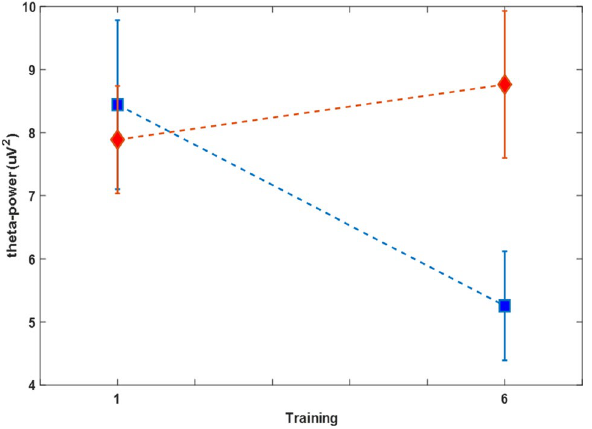
Figure 5. Pain evoked theta-band power. Mean power from 200 to 350 ms (3–5 Hz) measure at before the first and before the last BCI-training. The interaction effect shows an increase of pain evoked theta-band power in the group that was trained to increase ongoing theta-band power (red) and a decrease in the down-group (blue). Error bars depict ± 1 standard error of the mean (SEM, n = 10 in each